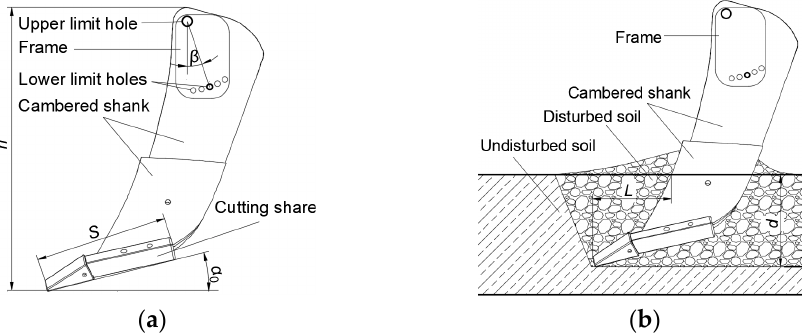
Figure 1. The ( a ) structure of bending subsoiling tool and ( b ) diagram showing the longitudinal distance ( L ) and working depth ( d ). ( α 0 , β , S and h stand for rake angle, mounting angle, length of cutting share and tool height, respectively).